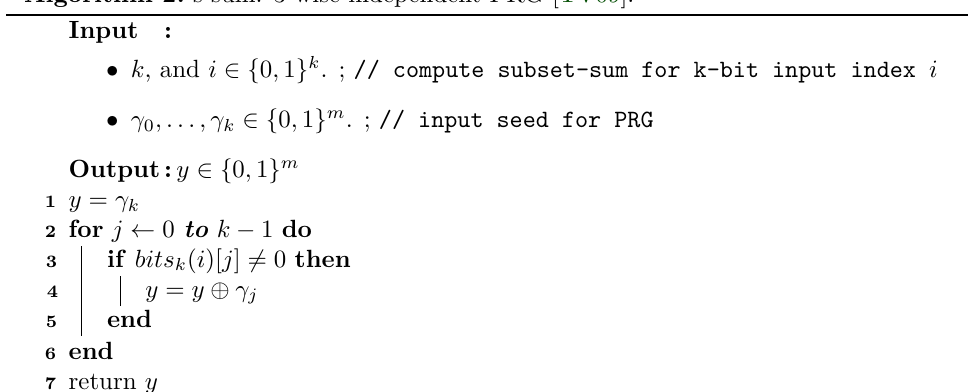
Algorithm 2: s-sum: 3-wise independent PRG